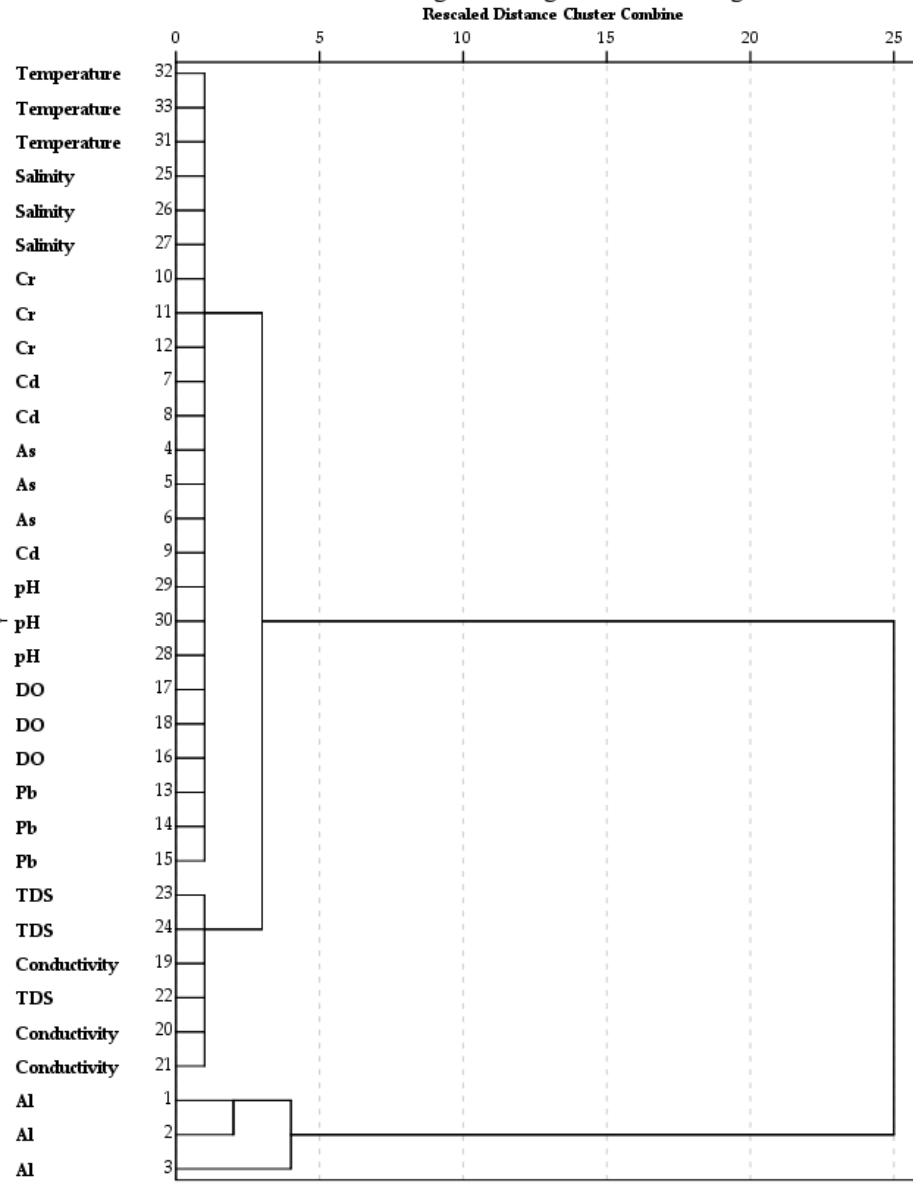
Figure 3. Clustering of metals and physicochemical parameters in the Langat River. Table 7. Pearson correlation among metals and physicochemical parameters.